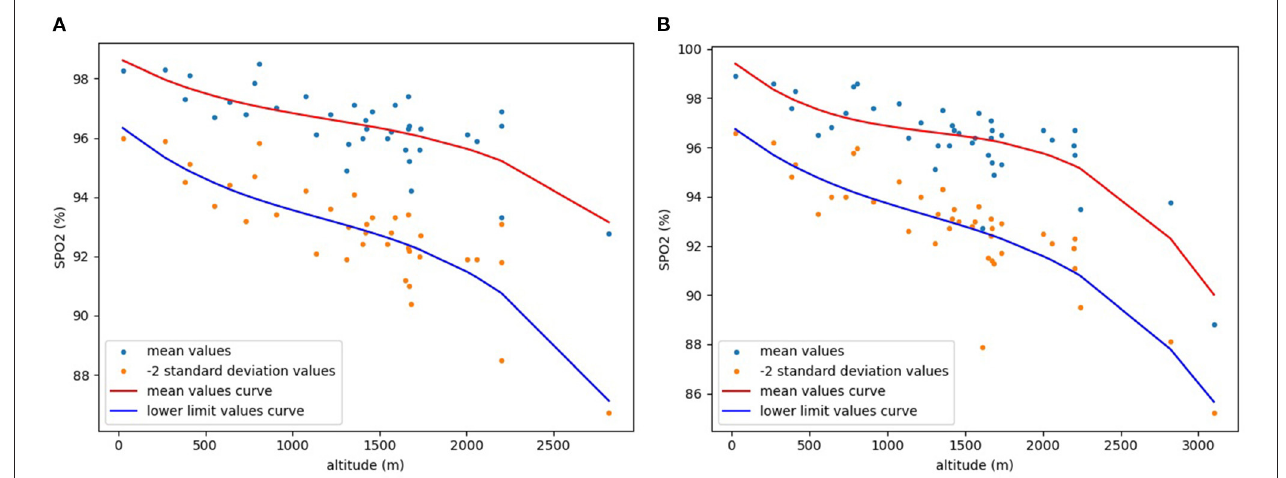
FIGURE 2 | Relationship between altitude and mean and lower limit values of SpO 2 in healthy neonates. (A) pre-ductal; (B)